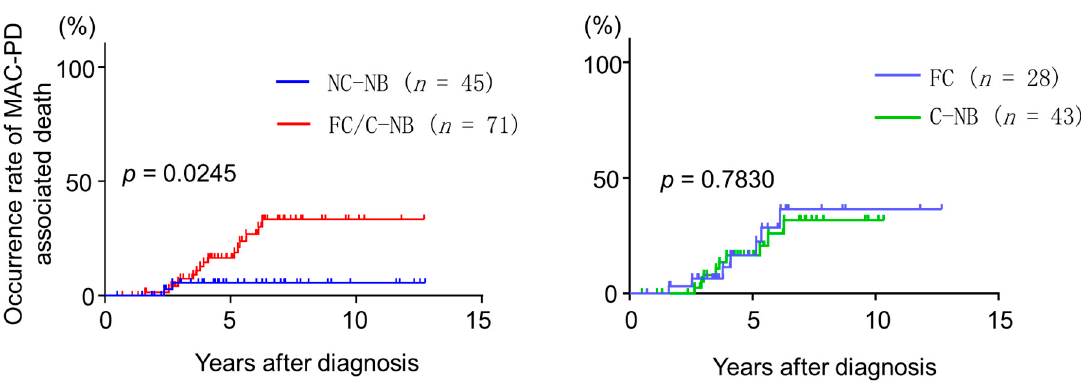
Figure 1. Occurrence rates of Mycobacterium avium complex pulmonary disease-associated death in patients with different forms of disease. The mortality rate of cavitary disease was high and different from that of non-cavitary disease. MAC-PD, Mycobacterium avium complex pulmonary disease; NC-NB, non-cavitary nodular bronchiectasis; FC, fibrocavitary form; C-NB, cavitary nodular bronchiectasis.